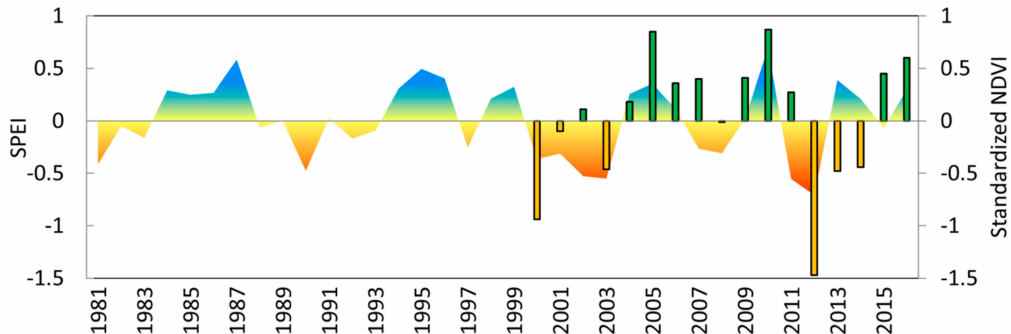
Figure 2. Annual standardized precipitation evapotranspiration index (SPEI) values (coloured area) and the standardized normalized difference vegetation index (NDVI) for August-September (green/yellow columns) for the study sites in the period 1981–2016 (NDVI data was provided by the Forest Monitoring and Measuring program of the Hungarian Forest Research Institute, [34]).